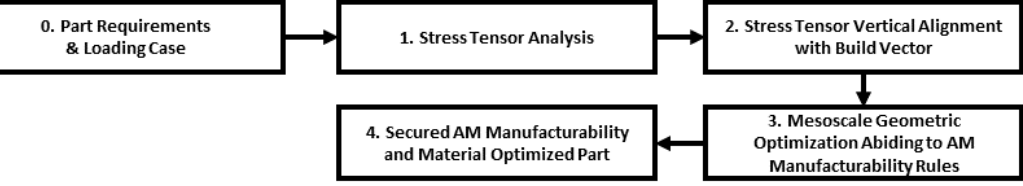
Figure 4. Shape optimization method flowchart.